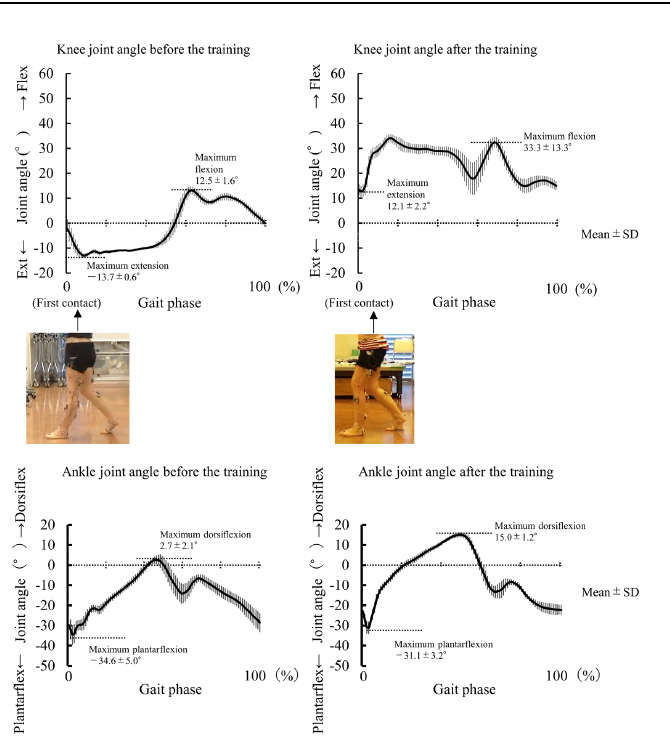
Figure 2. Knee and ankle joints angle on the affected side during gait before and after nine days of robot-assisted gait. The graphs indicate the knee and ankle joints angle during barefoot overground walking before ( left ) and after training ( right ). The horizontal axis indicates one gait cycle, with 0% indicating initial foot contact on the affected side and 100% indicating the next contact. The thick solid line represents the mean angle, and the thin vertical line represents the standard deviation. As the patient’s photographs show, genu recurvatum was seen before the training, but it disappeared after the training. The maximum knee extension angle changed from −13.7° to 12.1°. The maximum knee flexion angle changed from 12.5° to 33.3°. The maximum ankle plantarflexion angle changed from −34.6° to −31.1°. The maximum ankle dorsiflexion angle changed from 2.7° to 15.0°.